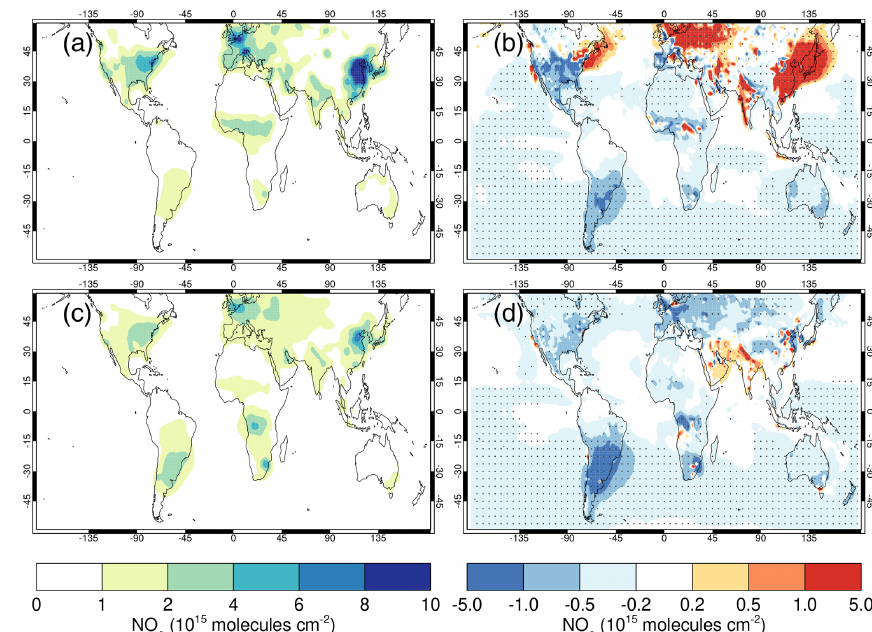
Figure 18. Comparison of observed and ND modelled UKCA StratTrop in UKESM1 tropospheric NO 2 columns (moleculescm − 2 ). Plots show seasonal means and differences for the period 2005–2014. (a) OMI tropospheric column (DJF); (b) difference between the model and OMI tropospheric column (DJF); (c) OMI (JJA) tropospheric column; (d) difference between the model and OMI tropospheric column (JJA). Stippling indicates grid points for which | bias | > satellite error.